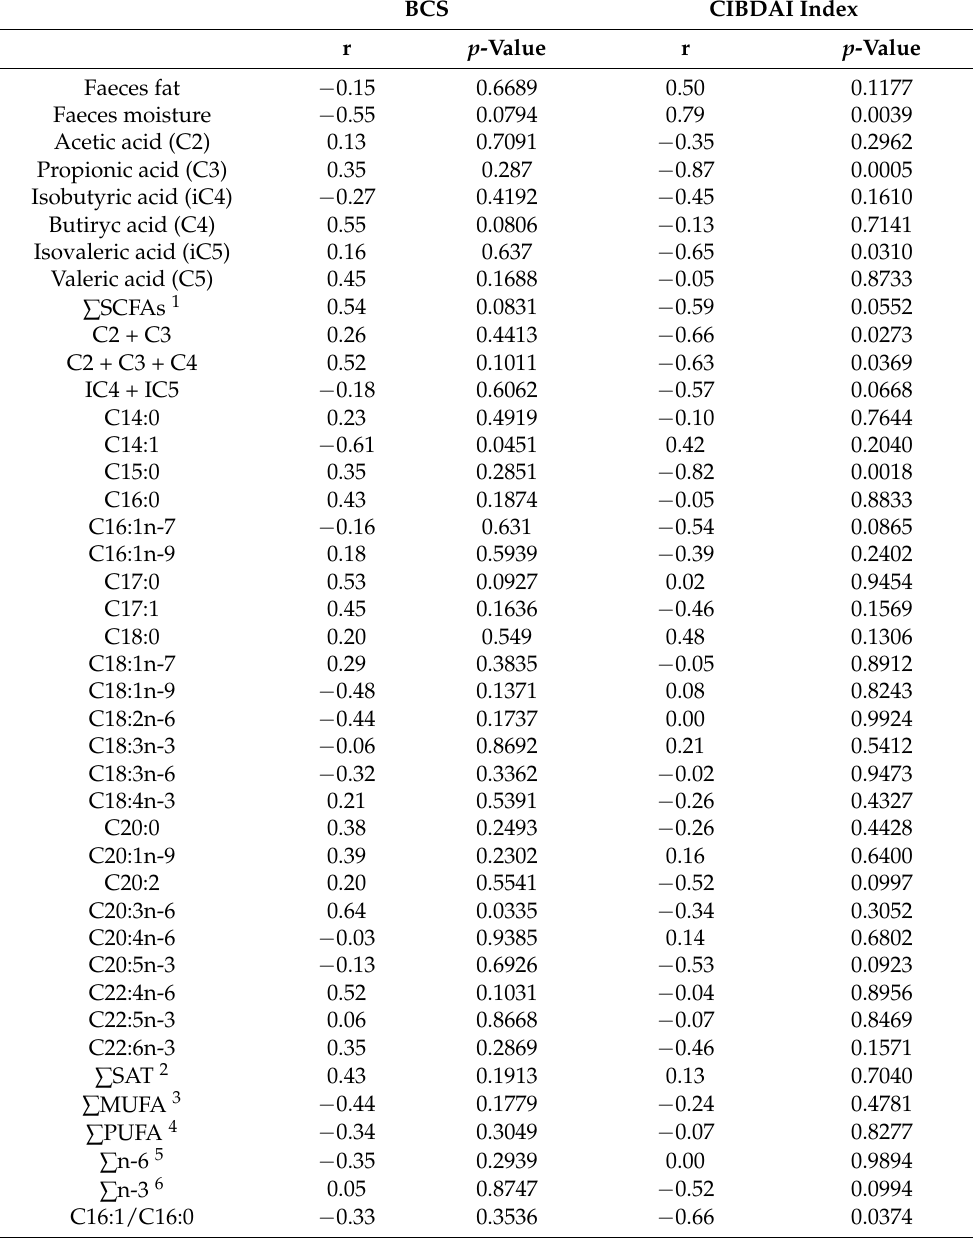
Table 7. Correlation coefficients between BCS (body condition score) and CIBDAI (chronic enteropa- thy activity index) and the other parameters of the faeces from the FRE (food-responsive enteropathy) and control